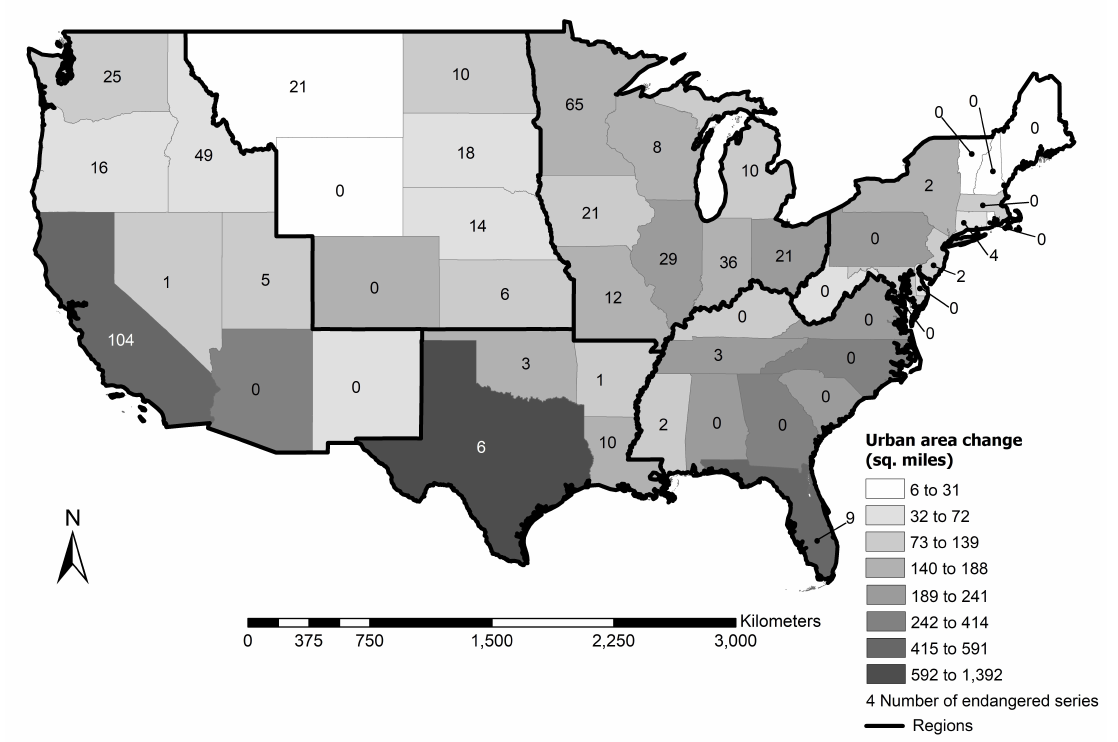
Figure 7. Urban land cover changes over time from 2001 to 2011 in the contiguous United States (U.S.) (adapted from Wentland et al. (2020)